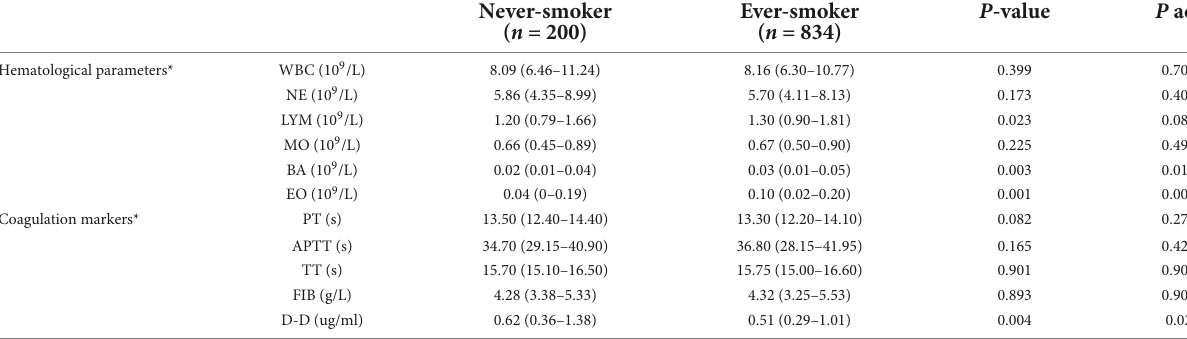
P -value P adj Ever-smoker ( n = 834)